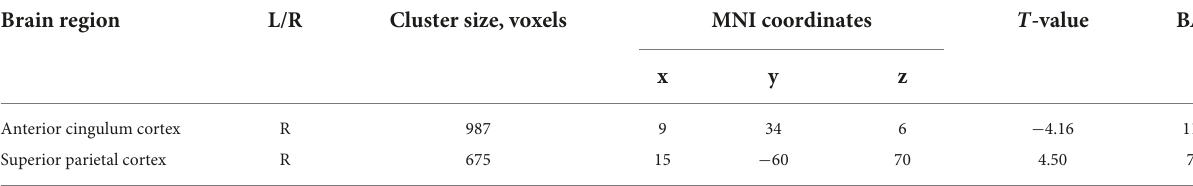
TABLE 2 Voxel-based morphometry comparisons between patients with menstrual migraine (MM) and healthy controls (HCs). Brain region L/R Cluster size, voxels MNI coordinates